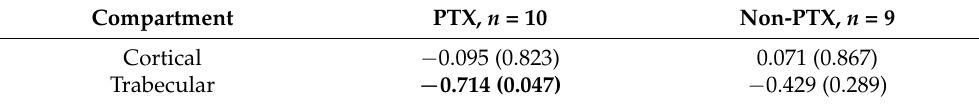
Table 2. Correlations between serum ipth and sclerostin expression per bone